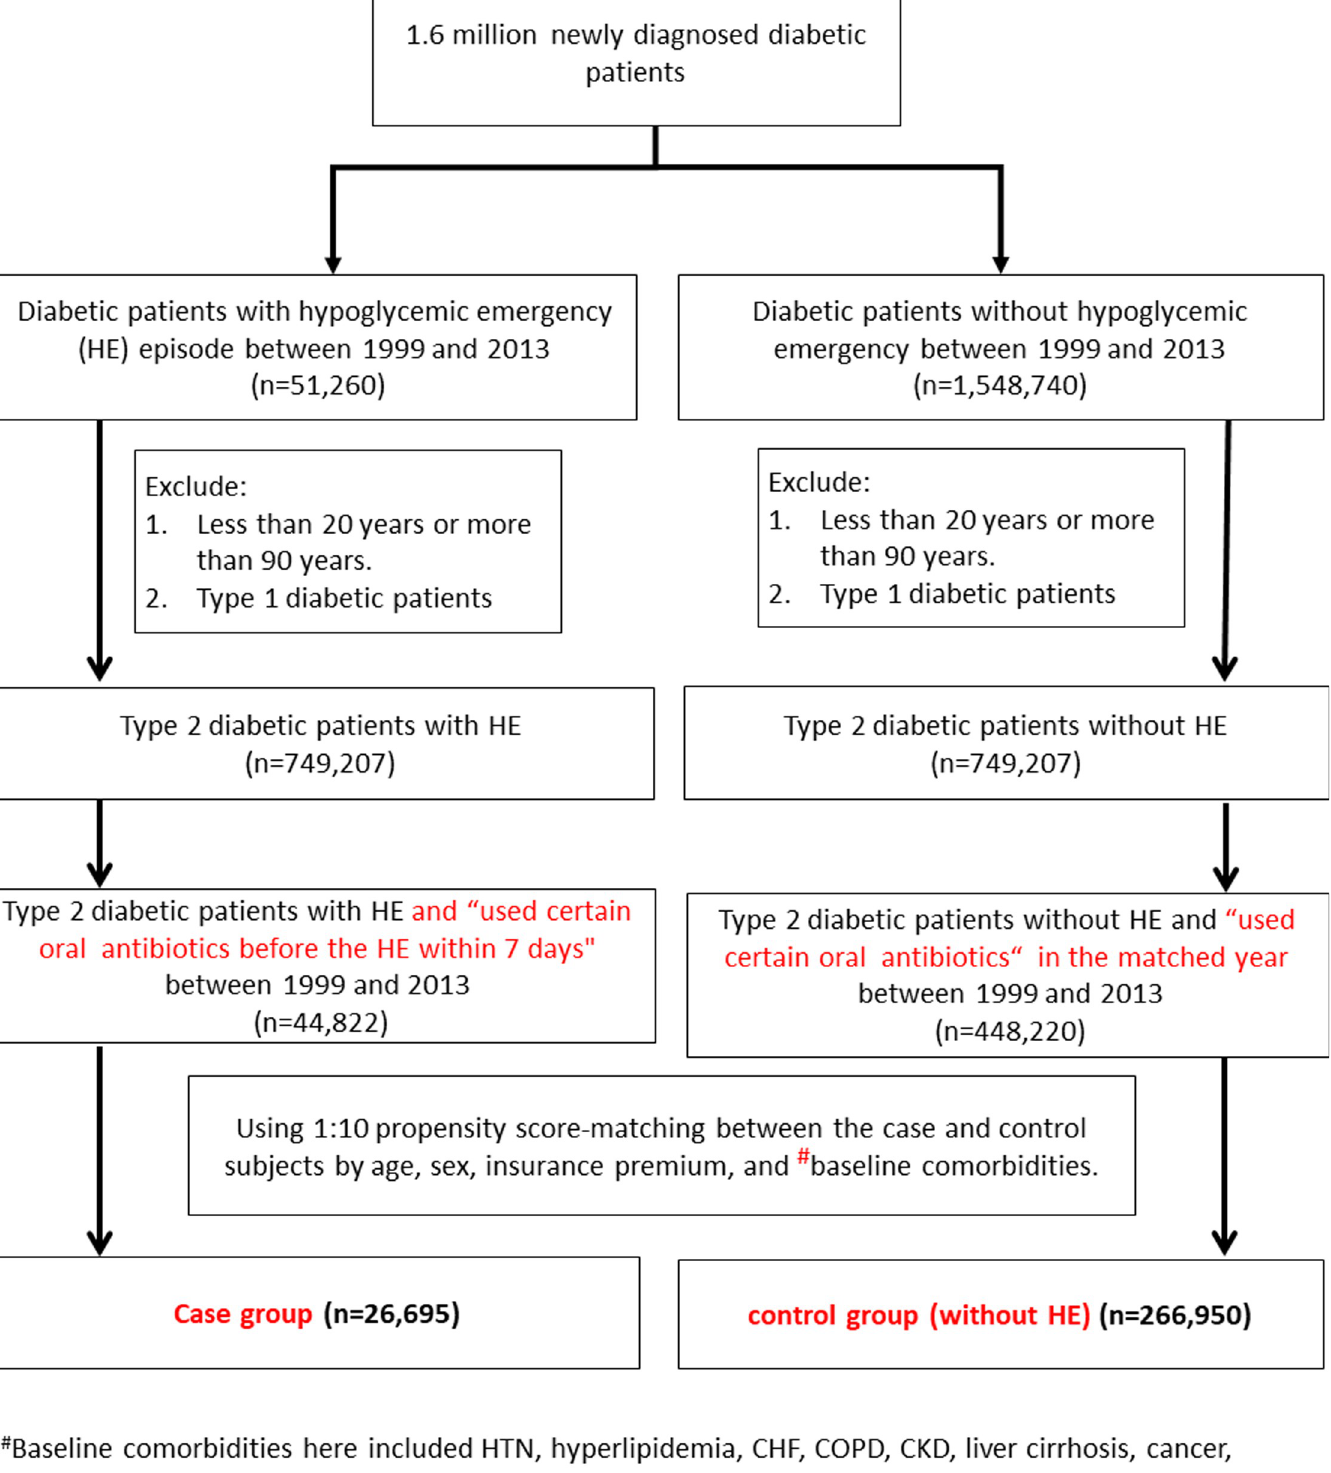
Fig 1. Selection algorithm for the case and control subjects in the study design.